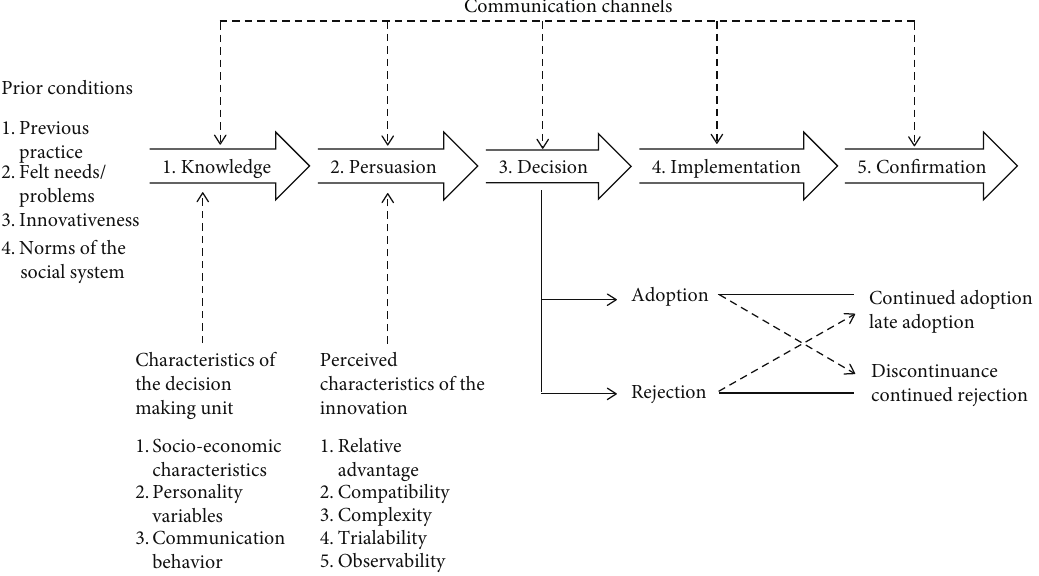
Figure 4: Model for innovation-decision process [16].